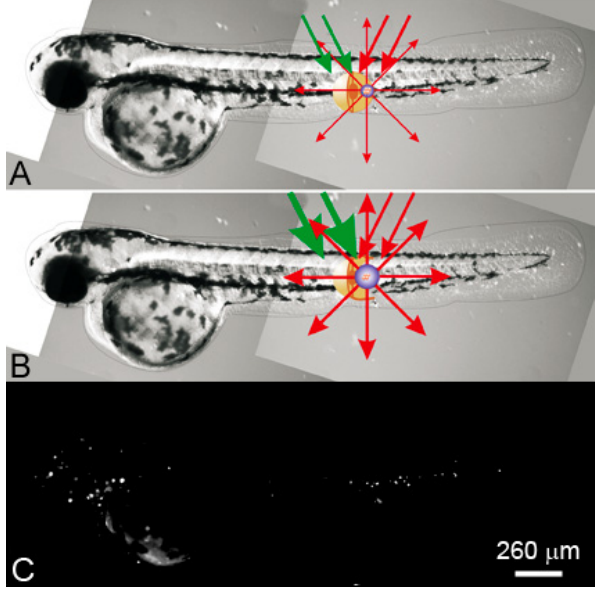
Figure 18. PNB theranostics in vivo includes the generation and detection of two sequential PNBs: ( a ) a small PNB is generated (with green pump laser pulse) in zebrafish in a specific cell and detected (with red probe laser pulse) thus sensing the cell; ( b ) the next, bigger PNB (generated with the second pulse of higher energy) destroys the cell, while optical scattering of the 2nd PNB guides the destruction; ( c ) fluorescent image of the embryo shows prostate labeled cancer cells scattered through its body